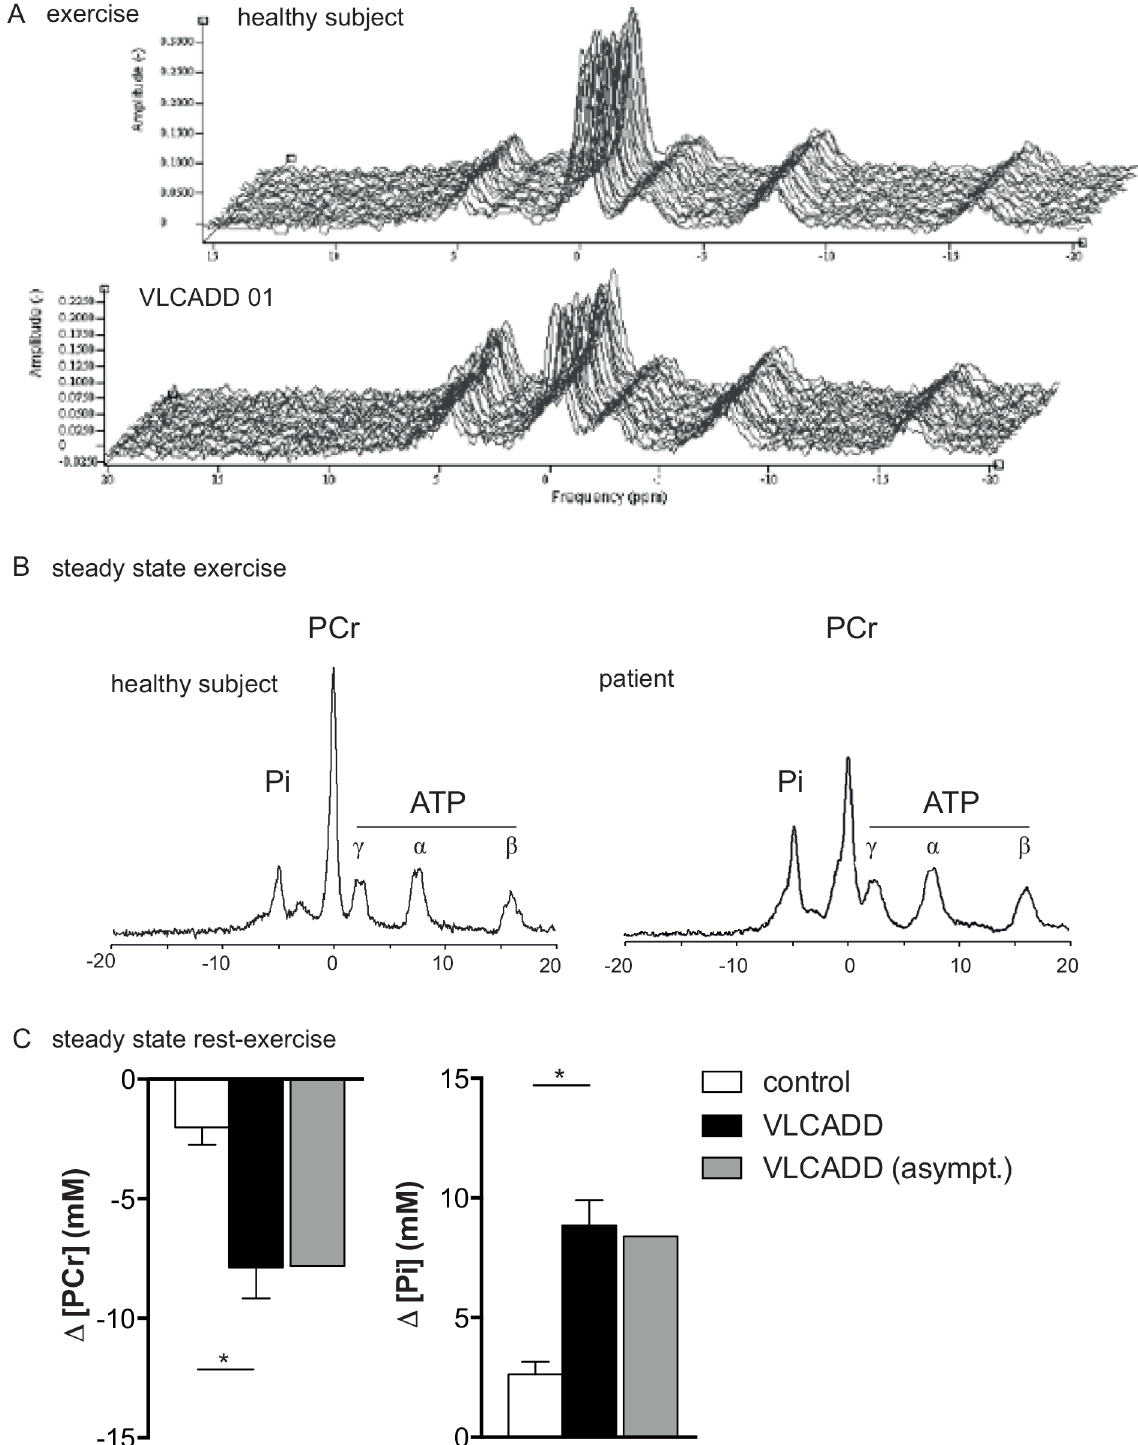
Fig 3. (A) 31 P NMR spectra acquired from the lateral head of the quadriceps muscle of the right leg of a VLCAD deficient patient versus a healthy control subject during 5 min of bicycling exercise at a workload equivalent to FATMAX in each subject. (B) Each spectrum represents the sum of the FIDs collected after 60 s of exercise. FIDs were apodized in the time domain using a 10-Hz low-pass filter prior to Fourier transform and phasing. Peak assignments: Pi inorganic phosphate, PCr phosphocreatine, ATP adenosine triphosphate (gamma, alpha and beta resonances, respectively). (C) Average change in PCr and Pi during exercise (in mM) in healthy control subjects versus symptomatic and asymptomatic VLCAD deficient patients. Error bars indicate mean ± SEM, * P < 0.05. doi:10.1371/journal.pone.0147818.g003 PLOS ONE | DOI:10.1371/journal.pone.0147818 February 16,